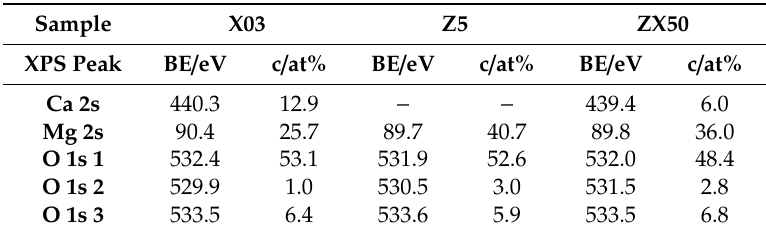
Figure 3. Survey X-ray photoelectron spectroscopy (XPS) spectra of sputtered samples ZX50 Table 3. The binding energies (BE) and atomic concentrations in the measured samples. Different components of O correspond to different compounds of O.